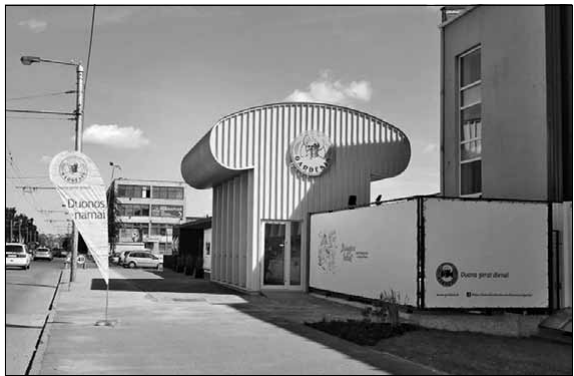
fig. 9. Gardėsis Bakery in Kaunas, by architect Karalius and designer Pranckevičiūtė,